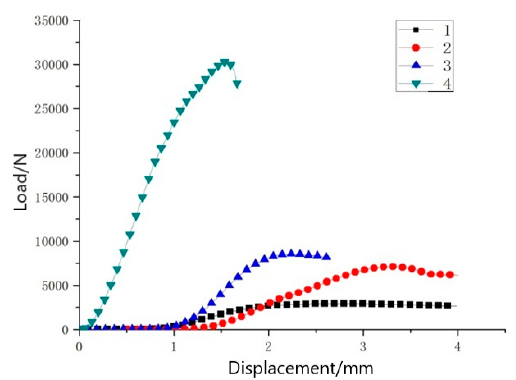
Figure 16. Sample load–displacement diagram.